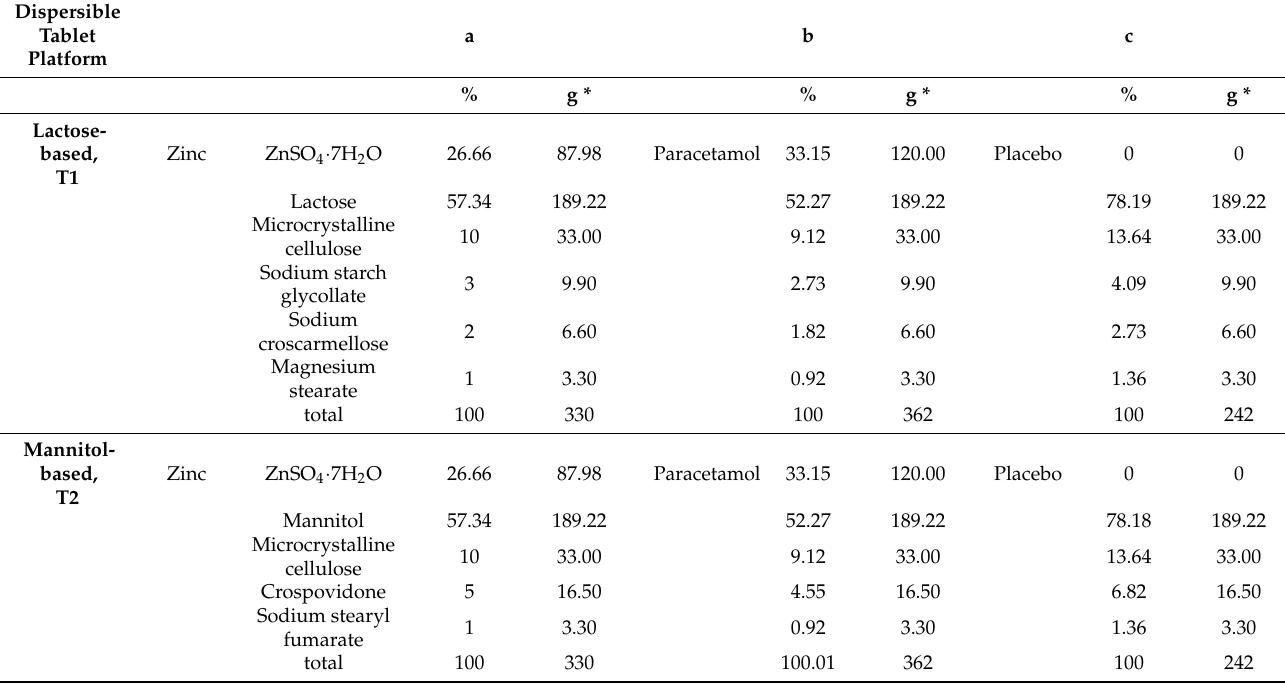
Footnotes: S3, S4. * Totals are rounded up to the nearest whole